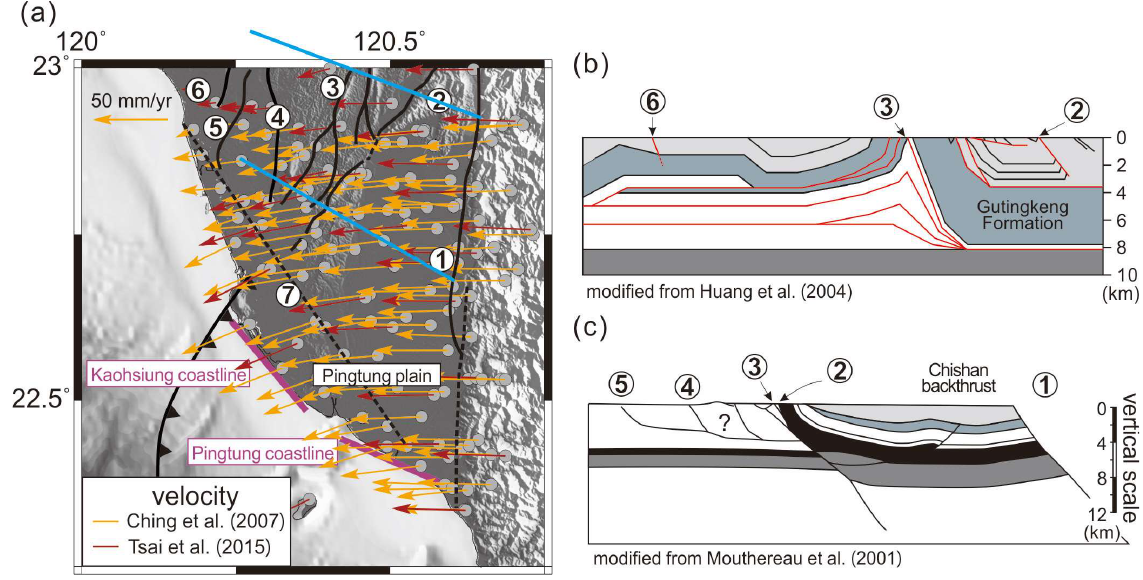
Figure 2. ( a ) The studied area. The main active faults are indicated with lines and numbers on the map. Gray dots represent the campaign GPS stations. The general strikes of the Kaohsiung and Pingtung coastlines are indicated, and these will be followed by the open boundary in our numerical models. ( b ) The balanced cross-section was modified from that of Huang et al. (2004) [13]. ( c ) The balanced cross-section was modified from that of Mouthereau et al. (2001) [12]. ① : Chaochou fault; ② : Chishan fault; ③ : Lungchuan fault; ④ : Hsiaokangshan fault; ⑤ : Chungchou fault; ⑥ : Houchiali fault; ⑦ : Fengshan fault.